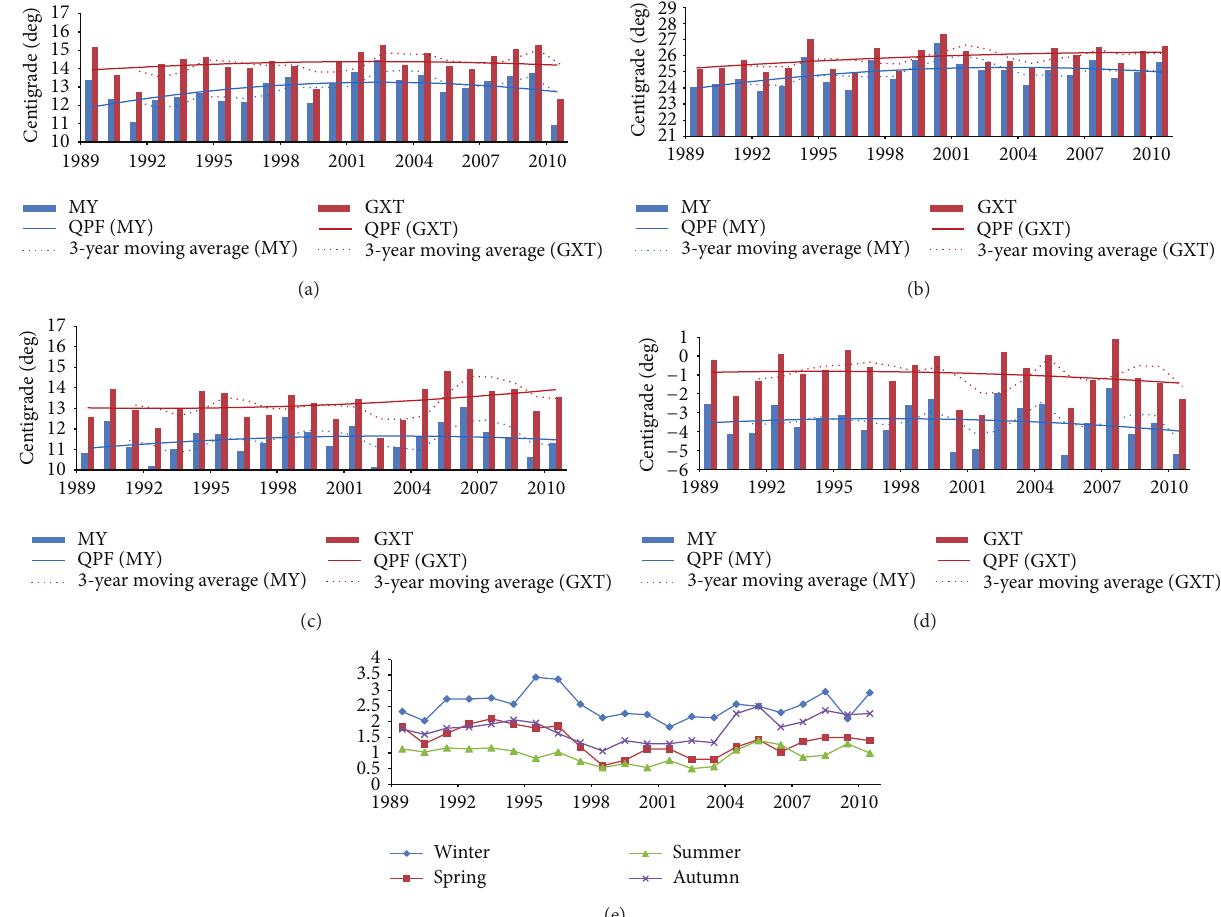
Figure 5: The mean temperature and Quadratic Polynomial Fitting (QPF) of Guan Xiang Tai (GXT) and Mi Yun (MY) of spring (a), summer (b), autumn (c), and winter (d), and temperature differences (e) between the two stations in the period of